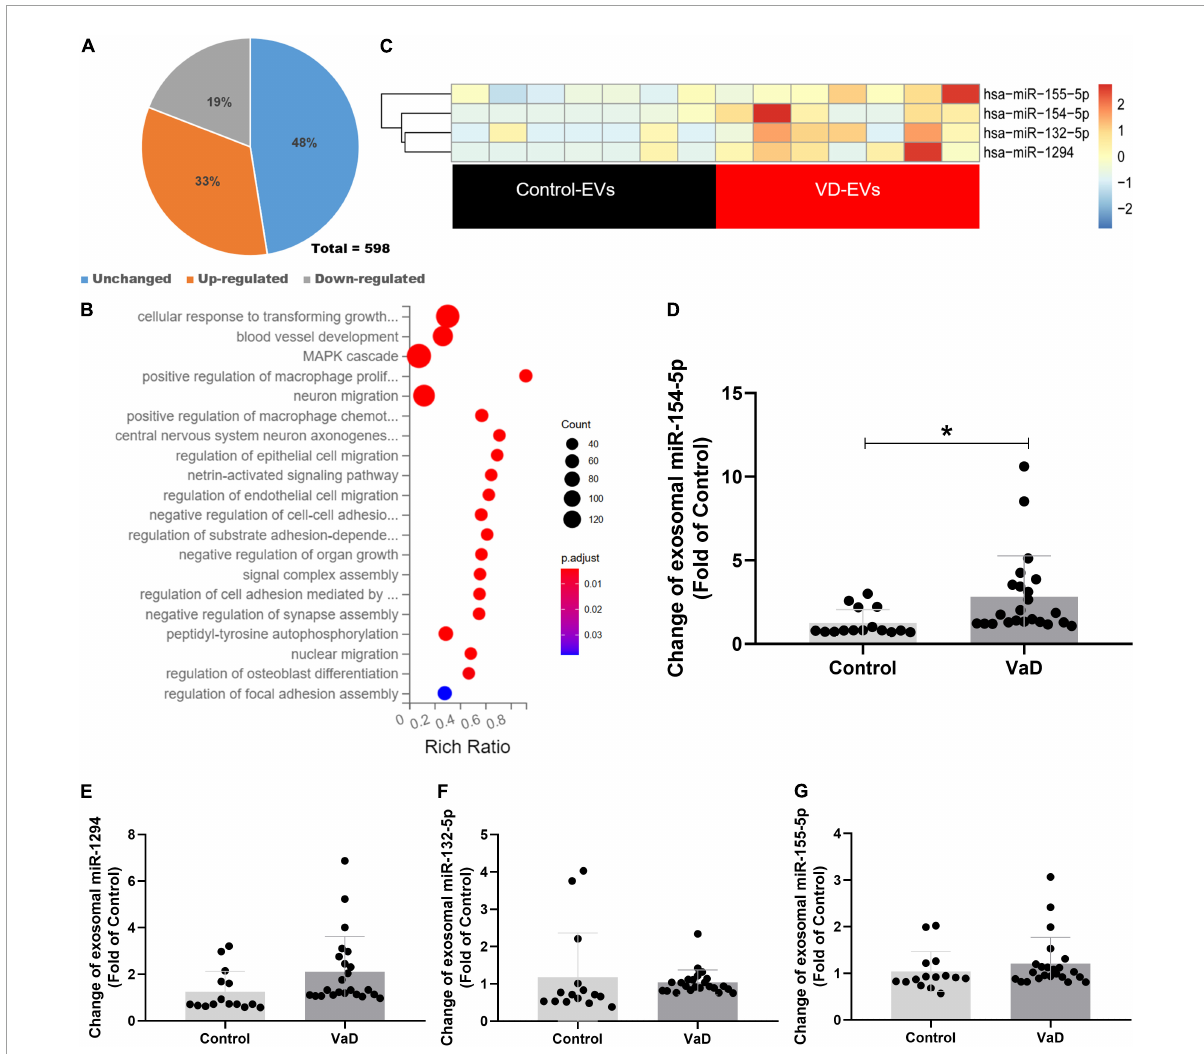
FIGURE2 Bioinformatics analysis of miRNAs expression profiles in serum exosomes of patients with VaD. (A) Pie chart of differentially expressed miRNAs. The Jacinth part presented upregulated miRNAs; the gray part indicated downregulated miRNAs; the blue part presented unchanged miRNAs. (B) Heat map of differentially expressed miRNAs from patients with VaD and control group. (C) The KEGG analysis of the pathways enriched by the differentially expressed miRNAs from patients with VaD. (D–G) The upregulated miRNAs were further verified using RT-PCR in patients with VaD and control group (Control: n = 13, VaD: n = 23). * p < 0.05. Data are shown as mean ± SD. KEGG, Kyoto Encyclopedia of Genes and Genomes; RT-PCR, reverse transcription polymerase chain reaction; VaD, vascular